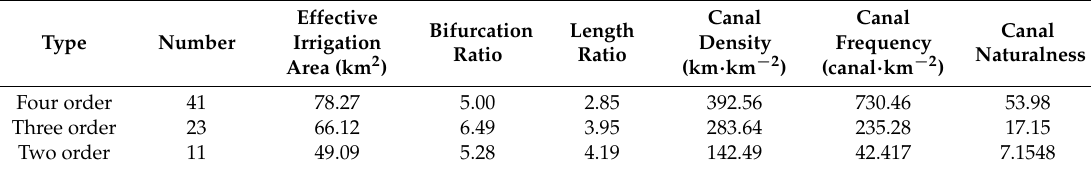
Table 1. Canal system characteristics of sample irrigation